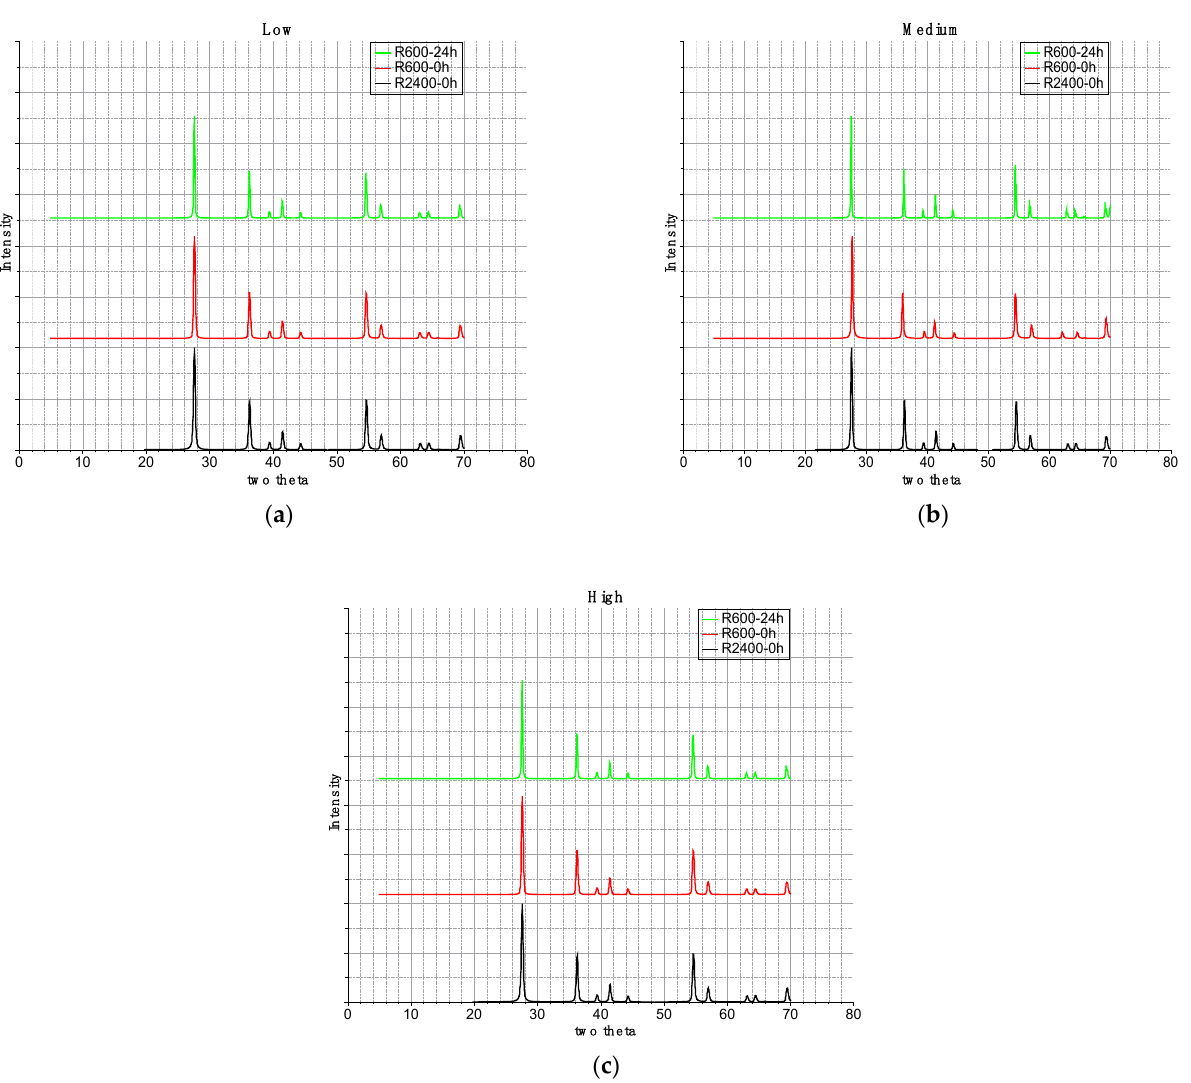
Figure 9. X-ray diffraction with normalized peak intensity of TiO 2 fiber samples with formula ( a ) low, ( b ) medium, and ( c ) high.